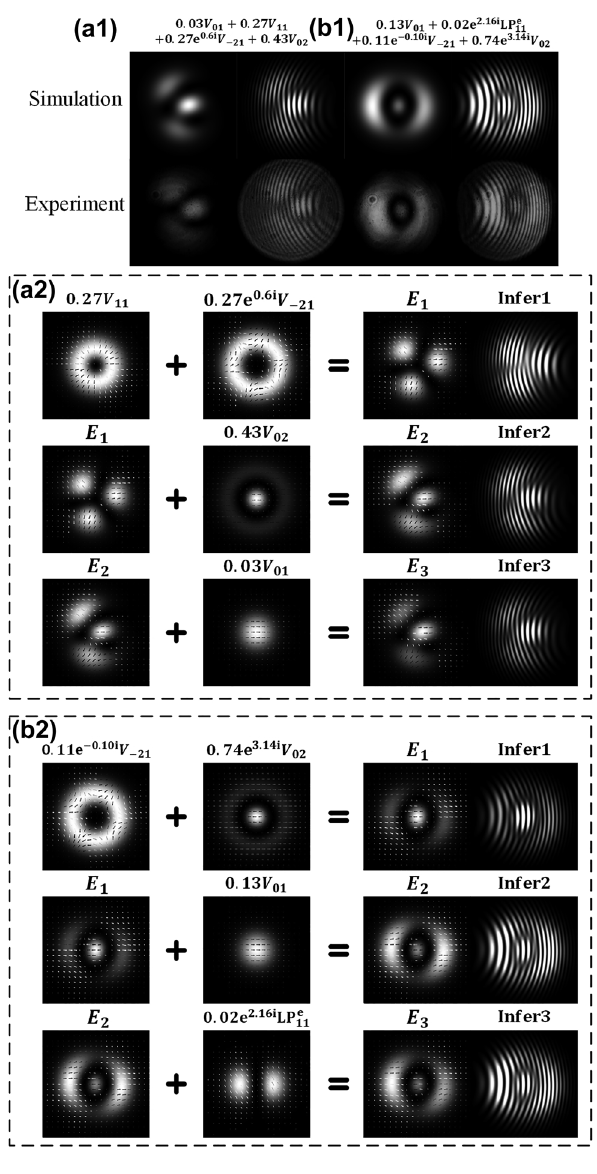
Figure 8: Process to recover detailed modal components based on the information of singularities obtained from detected light spots. The simulation and experiment patterns of structured lights from four-mode fiber with the recovered modal components as (a1) 0 . 03 V 01 + 0 . 27 V 11 + 0 . 27e 0 . 6i V − 21 + 0 . 43 V 02 and (b1) respondingrecoveringprocessesareprovidedin(a2)and(b2).Infer, interference